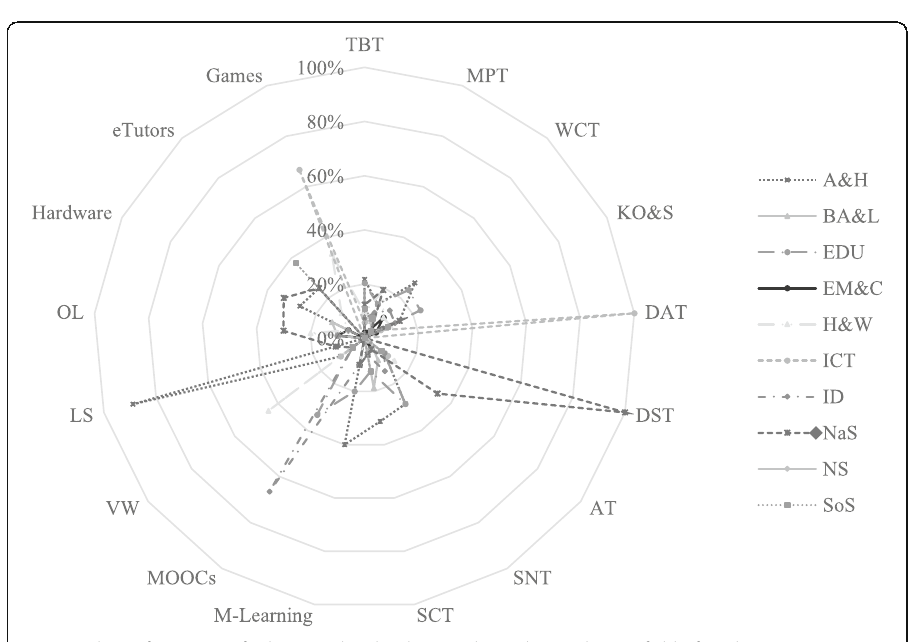
Fig. 9 Relative frequency of educational technology tools used according to field of study. Note. TBT = text- based tools; MPT = multimodal production tools; WCT = website creation tools; KO&S = knowledge organisation and sharing tools; DAT = data analysis tools; DST = digital storytelling tools; AT = assessment tools; SNT = social networking tools; SCT = synchronous collaboration tools; ML = mobile learning; VW = virtual worlds; LS = learning software; OL = online